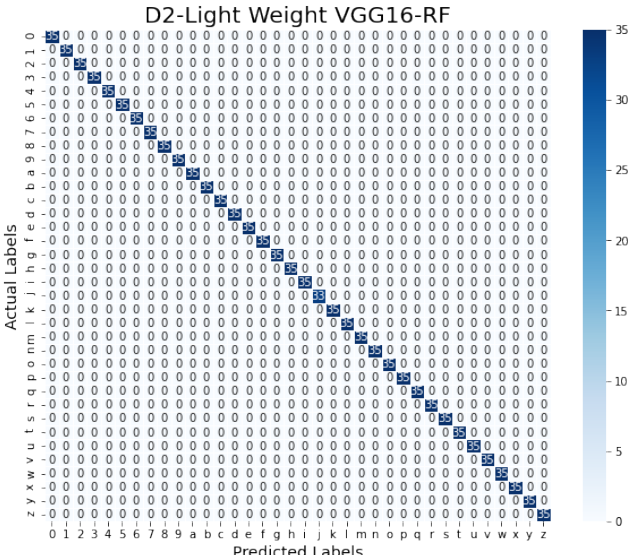
Figure 10. The confusion matrix of the lightweight VGG16-RF on the ASL Digits